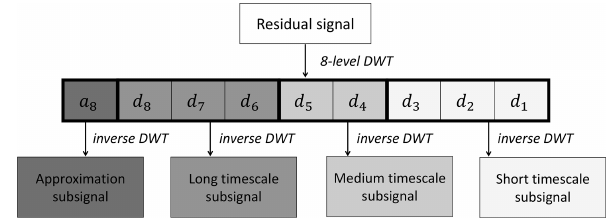
Figure 4. The proposed MRA scheme, implemented according to the characteristics of the residual signal.